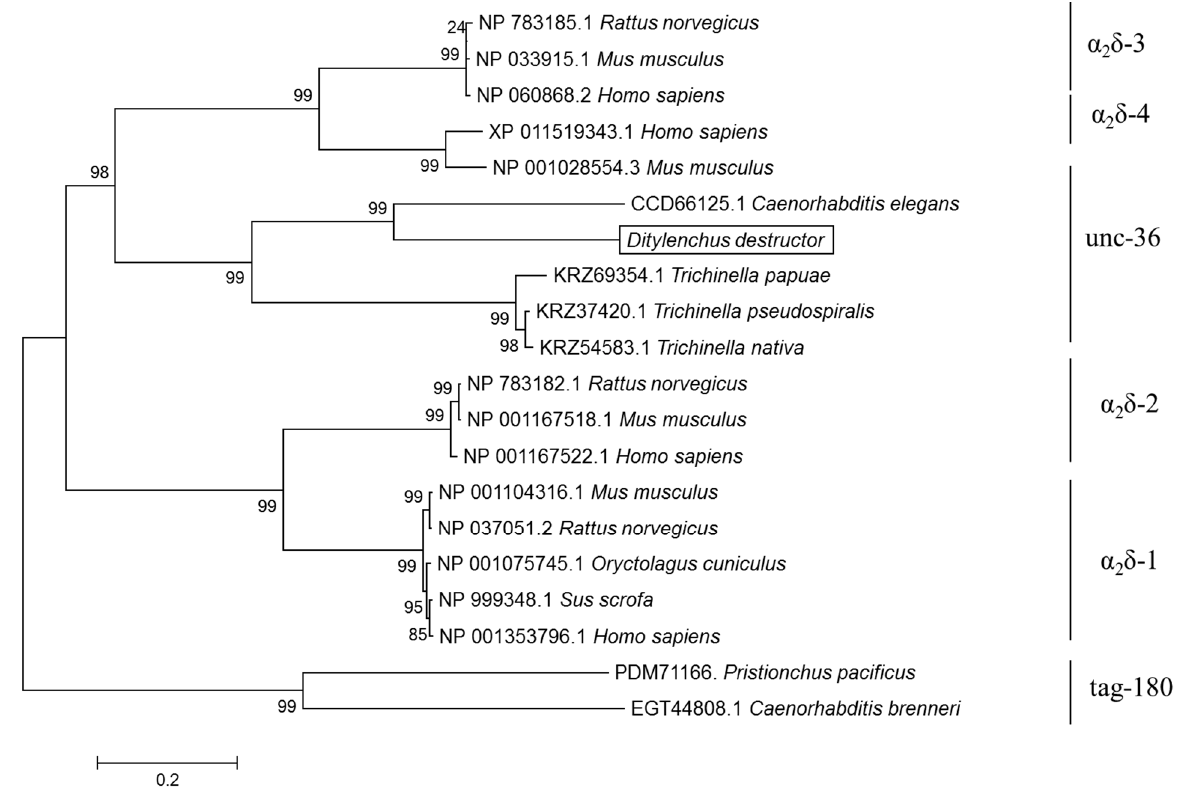
Figure 4. Phylogenetic analysis of DdCa v α 2 δ with α 2 δ genes from other species. The phylogenetic tree was constructed from the amino acid sequences of 20 VWA structural domain-containing α 2 δ genes. The tree was constructed using MEGA 6.0 based on the neighbor-joining method according to the amino acid sequences. The phylogenetic tree and sequences of other species were in the NCBI database; accession numbers are shown in Table 2. Table 2. DdCa v α 2 δ information used for sequence alignment and phylogenetic analysis.